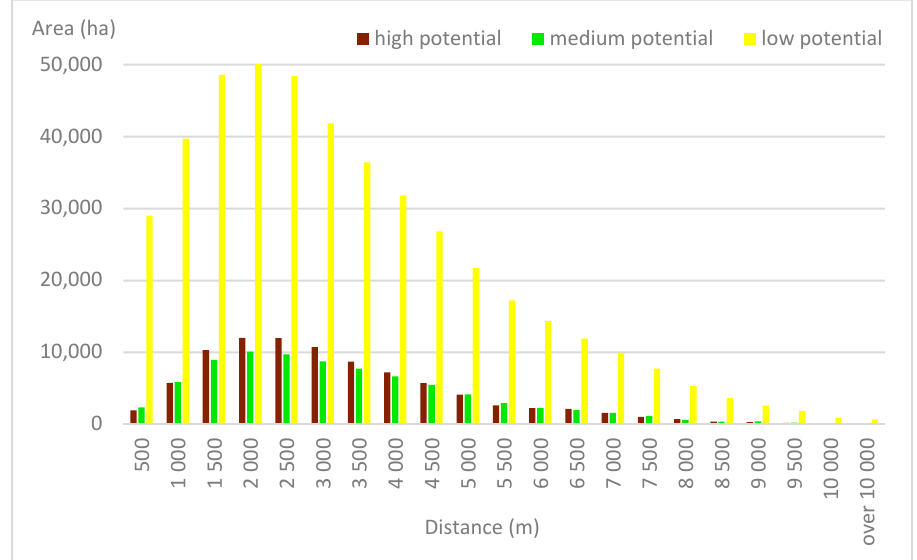
Figure 4. Occurrence of the potential for mushrooms within distance zones from the settlements.